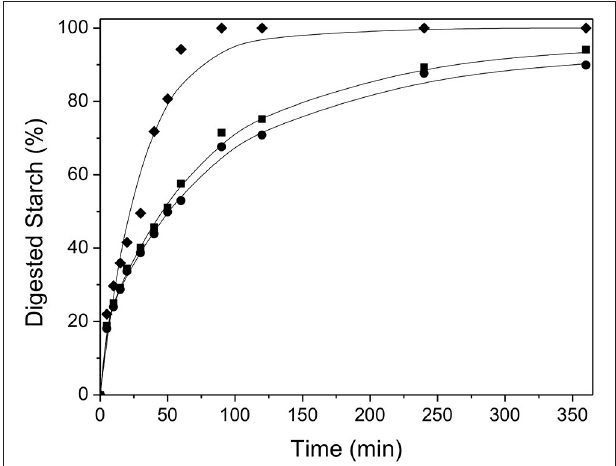
FIGURE 7 | Hydrolysis kinetics and fitting curve for yogurt with the extruded flours of whole unripe plantain (UPFW, •) and flours from the fruit pulp (UPFP, (cid:4) ). Regular maize starch (gelatinized by 10min boiling) was used as reference ( (cid:7) ). The lines depict least-squares numerical fitting. Symbols ( (cid:4) , •, (cid:7) ) are experimental data.